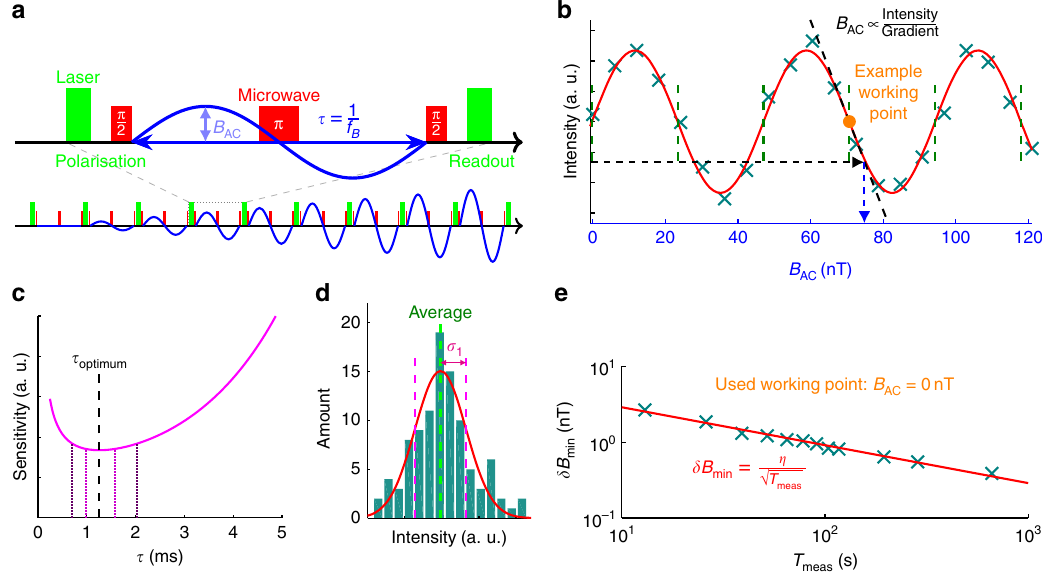
Fig. 3 Alternating current (AC) magnetic fi eld measurement. a Pulse sequence for a B AC measurement. It is a Hahn-echo sequence (see Fig. 2c) with a synchronised sinusoidal AC magnetic fi eld, which changes its sign during the π -pulse. Hence, the fi nal phase depends on the magnetic fi eld amplitude. A total sequence for a measurement like b is given at the bottom, where the amplitude of the magnetic fi eld is increased at each Hahn-echo sub-sequence. The fi nal microwave π /2-pulse is along the y axis, so that, at B AC = 0 T, the gradient is at a maximum. b Single measurement to fi nd the working points that have the maximum gradient (100,000 iterations, data with blue crosses, sinusoidal fi t with red line). The working point indicated with an orange circle is an example, the dashed arrows show how a measured intensity translates to a magnetic fi eld amplitude. c Theoretical sensitivity vs the time period of the magnetic fi eld derived from the T 2 data (see Supplementary Note 5), giving an optimum period τ optimum ( = 1/ f B ,optimum ) of 1.2 ms. The inner-magenta/ outer-purple dotted vertical lines mark the range of periods for which the difference with the optimum sensitivity remains within 2%/10%, respectively. d Histogram of the repeatedly measured Hahn-echo intensity at working point B AC = 0 T to determine the uncertainty σ 1 . For the vertical axis of b and the horizontal axis of d , the same units and scale are used (since the same analysis method is applied), so they cancel when computing δ B min . e Logarithmic plot of δ B min vs T meas (data with blue crosses, fi t to δ B min = η / T meas with red line, η ¼ 9 : 1 þ 0 : 3 (cid:4) nT Hz − 1/2 ) 0 : 3 NATURE COMMUNICATIONS| (2019) 10:3766